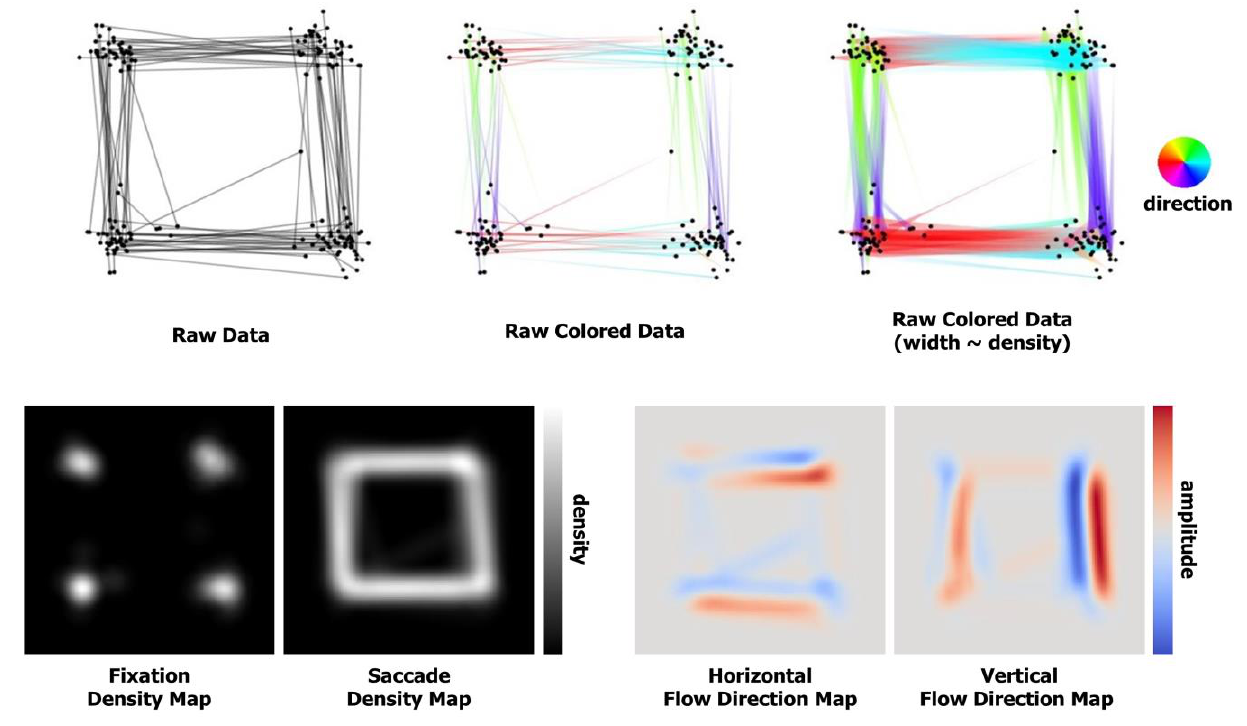
Figure 1. Different representations and maps of the raw